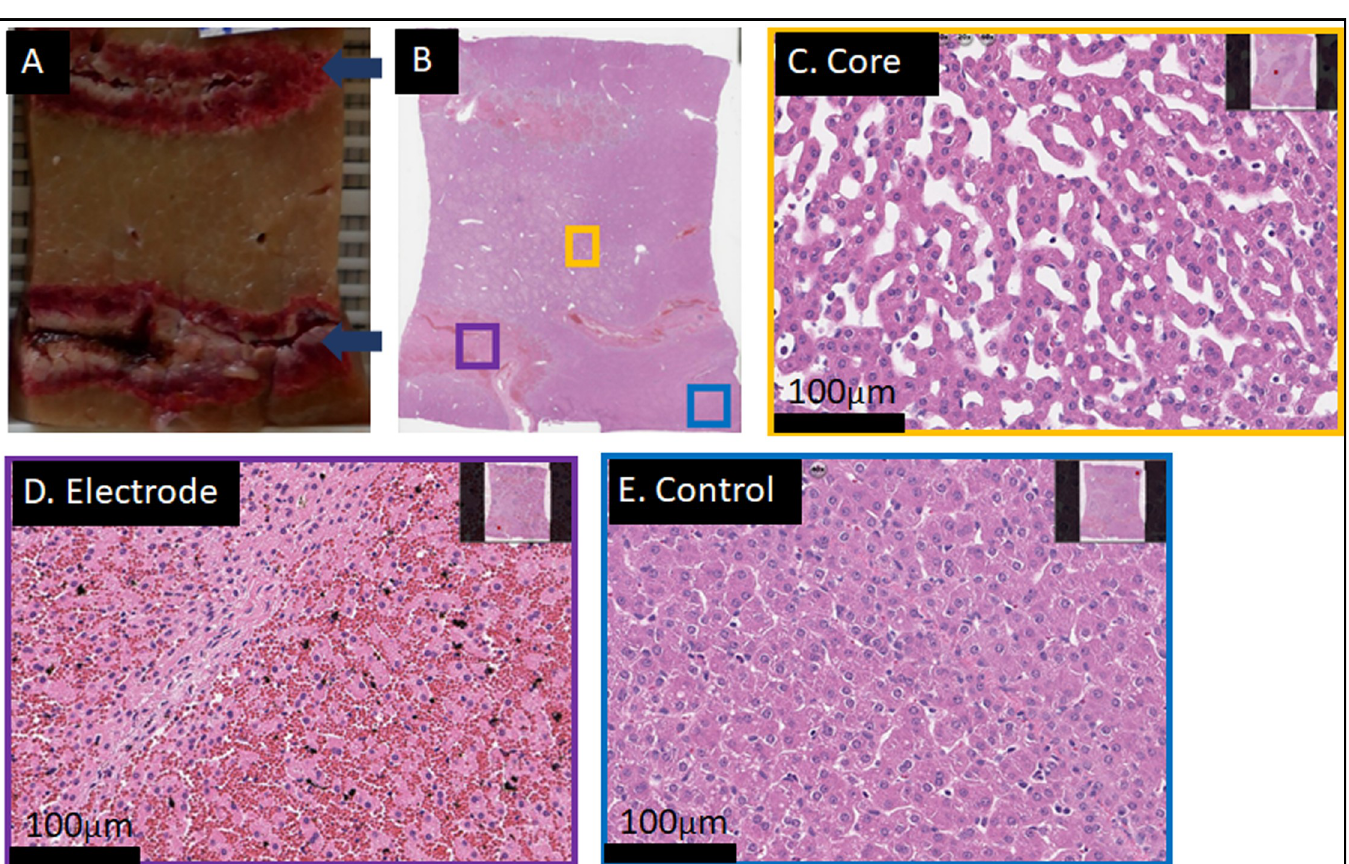
Fig 5. Example of a non-bridged 2-electrode ablation. Two waveforms at 1600V and 1500V peak voltage were applied, delivered with 13G diameter electrodes at 20mm distance and 30mm exposure length. Total time required was approximately 5s, however the waveforms were cut off early by the software, leading to incomplete discharge and hence incomplete delivery and distribution of electrolysis. Liver harvest was 22h post treatment. (A) Macroscopic image of the lesion, which shows healthy looking tissue between the electrodes (electrode track is visible as deeply darkened tissue, direction is indicated in dark blue arrows). (B) H&E staining of the entire lesion. (C) H&E stained tissue sample at 20x magnification from the core region (yellow insert in B). Sinusoids and cells appear affected, but not dead. (D) H&E stained tissue shows complete cell death and disrupted cellular infrastructure at the electrodes at 20x magnification (purple insert in B). (E) H&E stained control area at 20x magnification, blue insert in